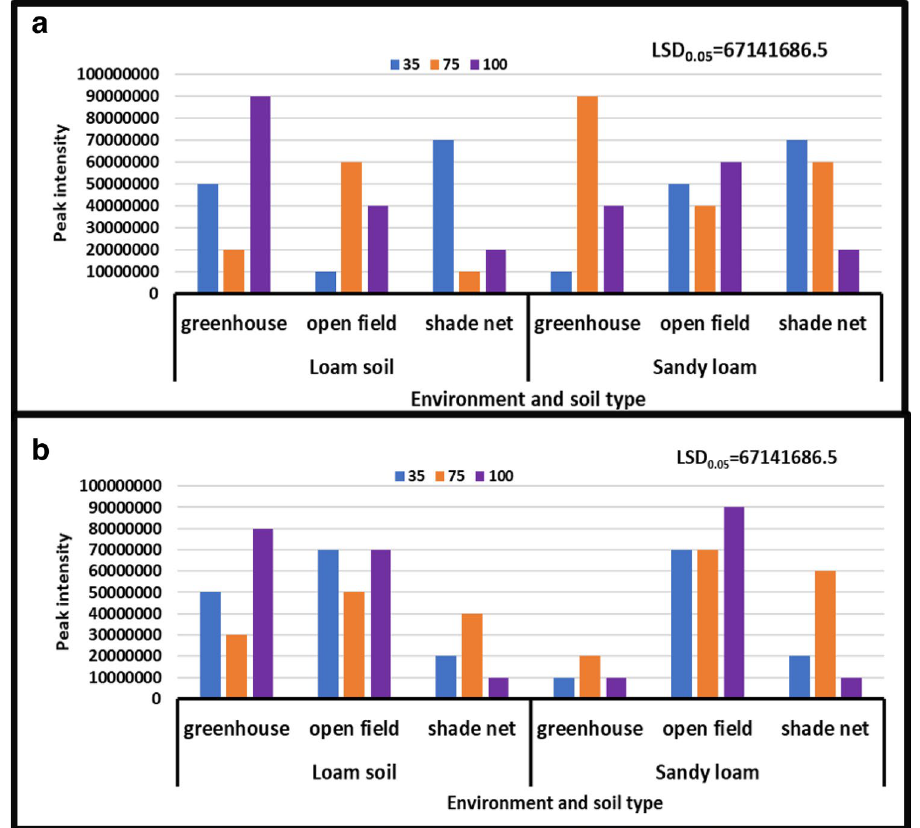
Figure 4. Treatment interaction effect on 4-hydroxyproline of African horned cucumber. 35 means severe water stress; 75 means moderate water stress; 100 means no water stress. Values are average over treatment; ( a ) means treatment interaction of water stress levels and soil types at different environments during the 2017/18 season; ( b ) means treatment interaction of irrigation water regimes and soil types at different environments during season 2018/19. Peak intensity showing LCMS-8040 triple quadrupole mass spectrometer intensities which represent the quantity of metabolites varying with treatments. LSD 0.05 is the least significant difference of